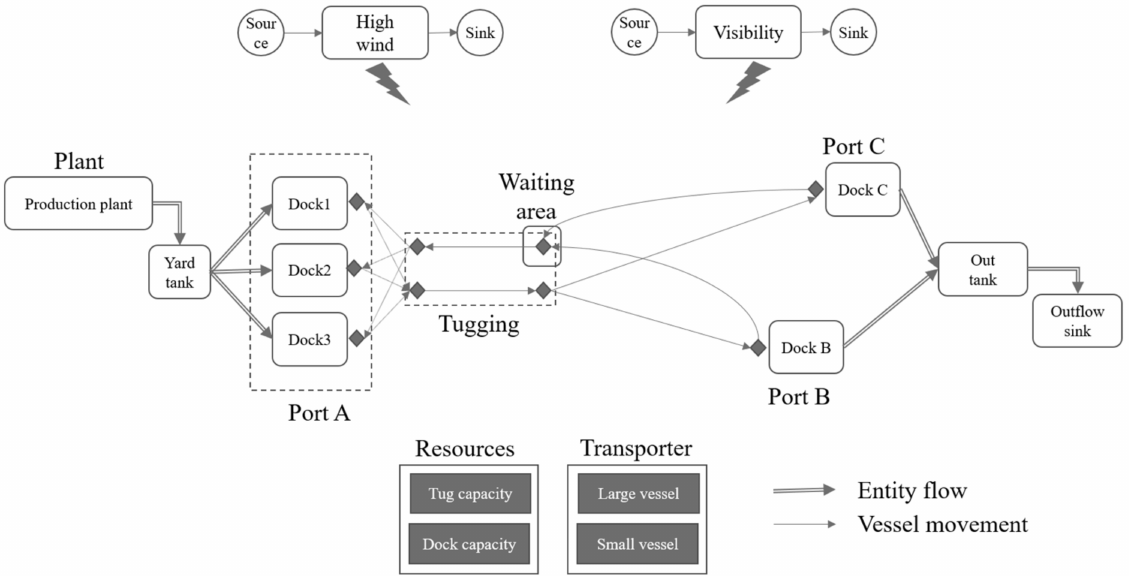
Figure 2. Schematic diagram of the simulation model for the closed-loop vessel shipping